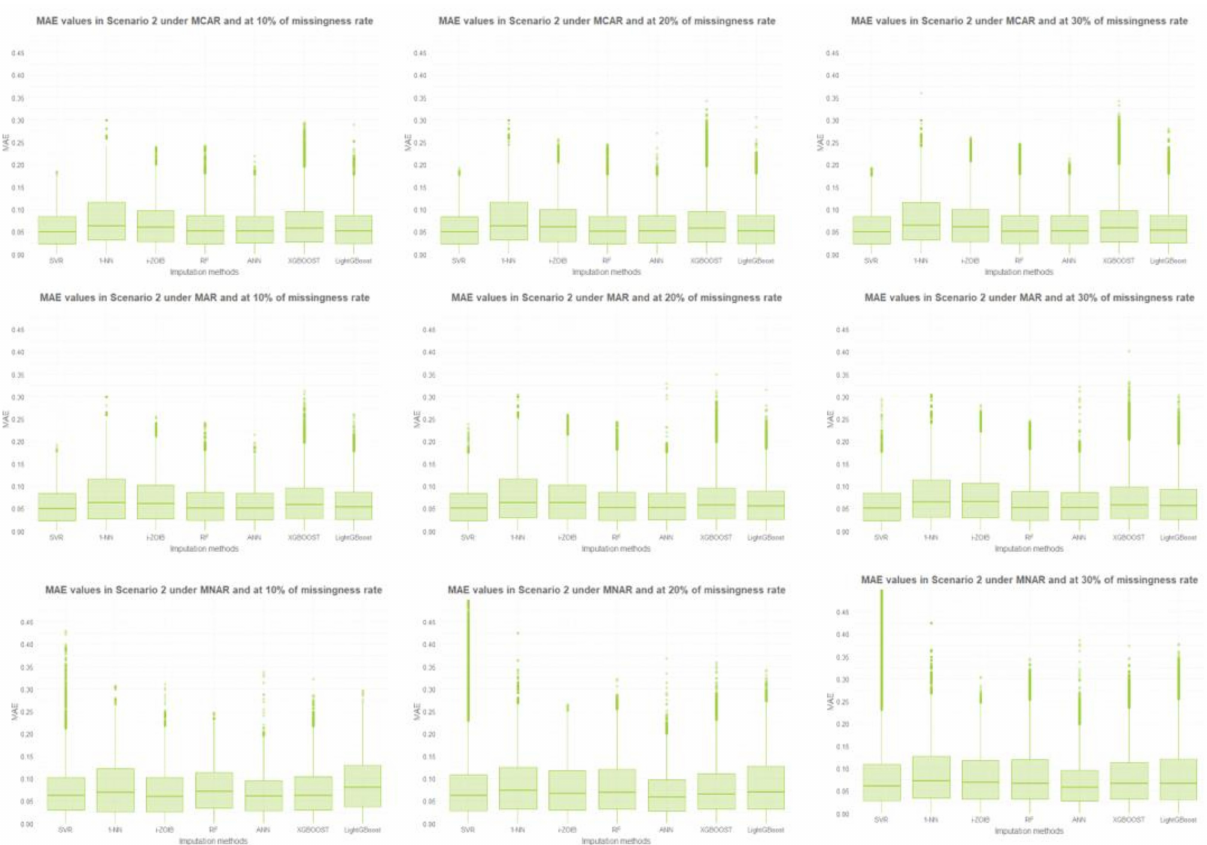
Figure 5. Boxplots of the MAE accuracy measure according to the missingness mechanisms, rates, and imputation methods (from left to right: SVR, 1-NN, i-ZOIB, RF, ANN, XGBOOST, LightGBoost) in the Scenario